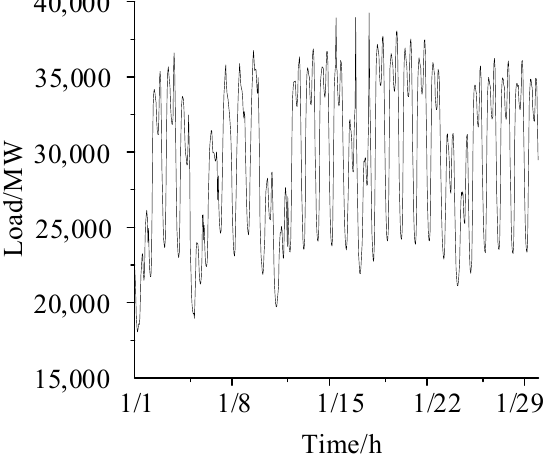
Figure 3. The raw data of power load.